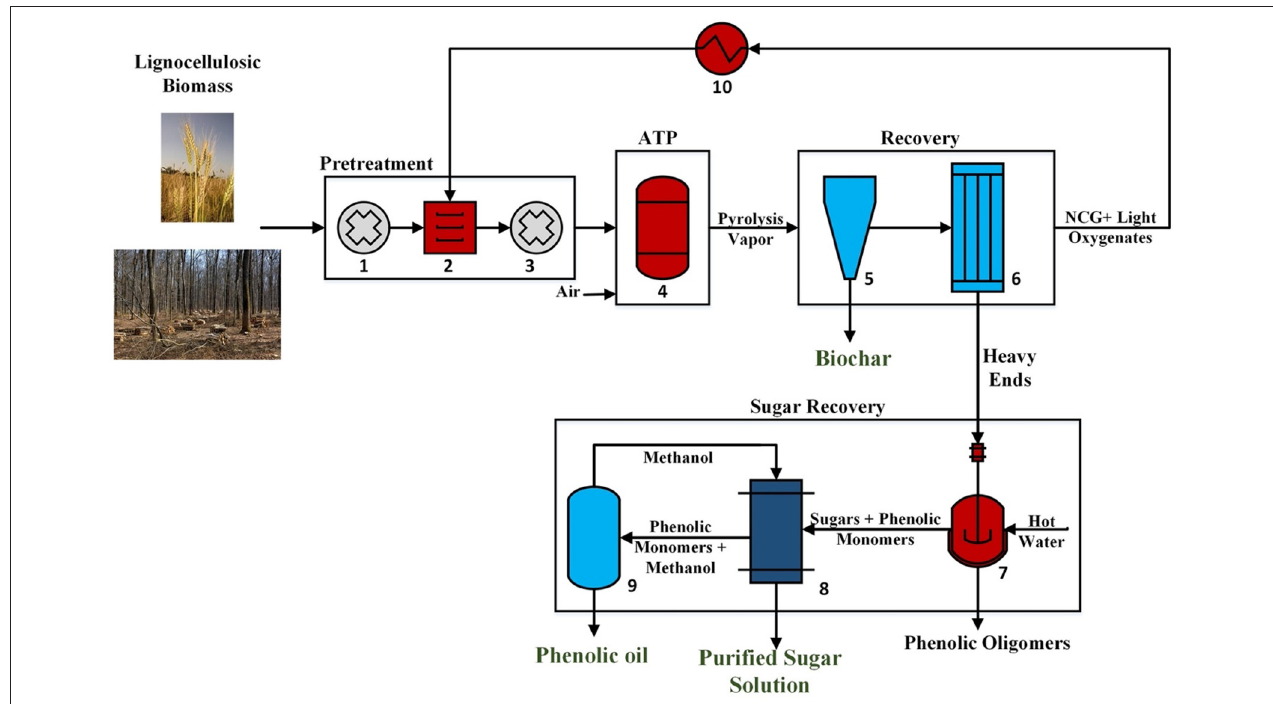
FIGURE 1 | Flow diagram of 250 ton/day lignocellulosic biomass-driven ATP system producing sugar, phenolic oil, and biochar.